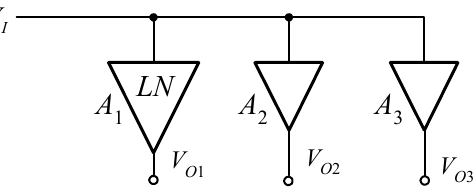
Figure 3. Amplifier configuration for gain calibration. A 1 is the low noise ( LN ) amplifier in Figure 1; A 2 and A 3 are operational amplifier (OA)-based amplifiers with stable and known gain.